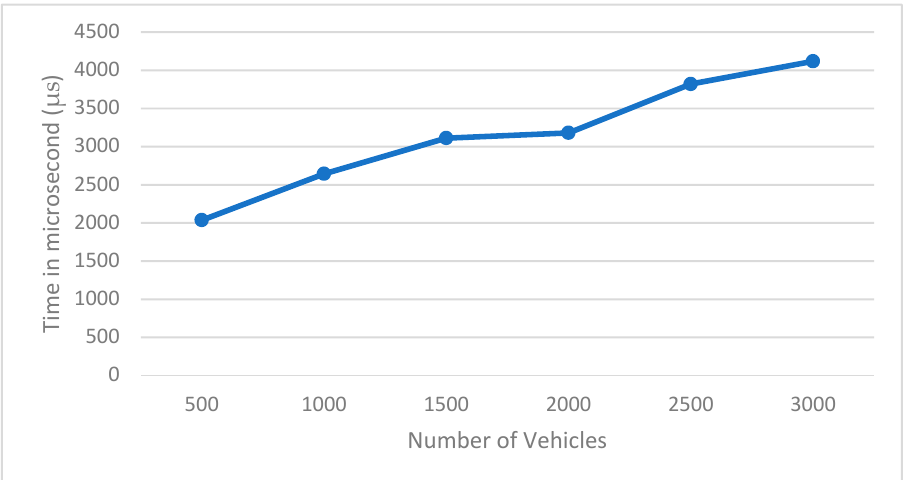
Figure 3. Data processing time